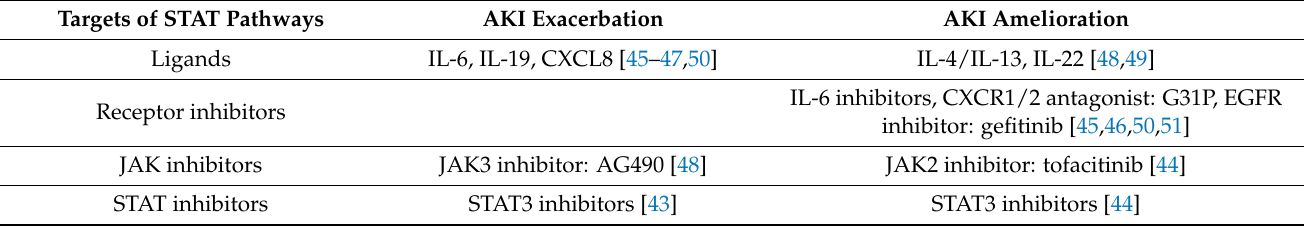
Table 2. Different roles of STAT pathways in Acute kidney